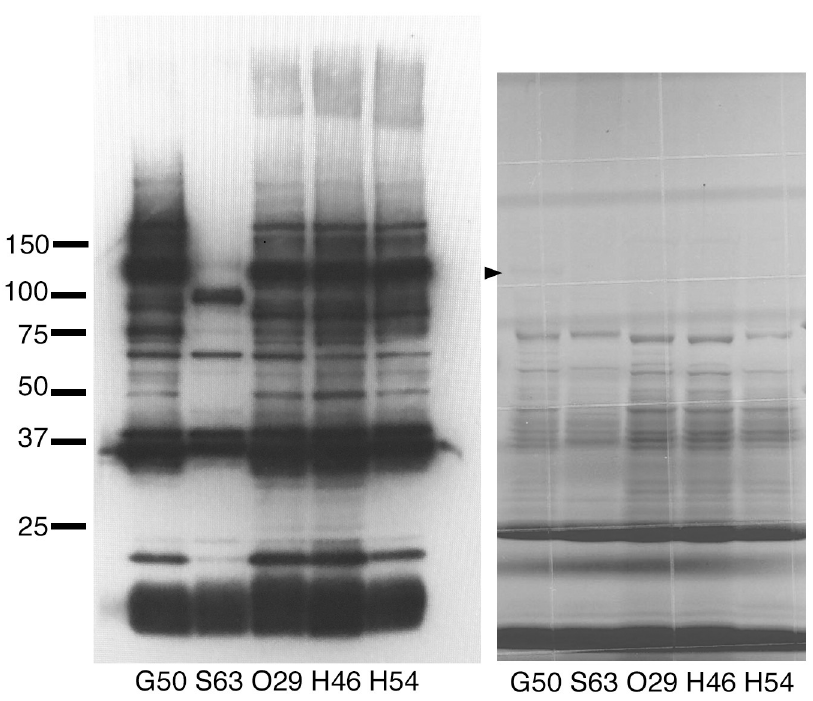
Fig 1. Western blot and Coomassie Brilliant Blue staining of lactococcal cell-wall proteins. (A) Western blot of cell-wall proteins of five lactococcal strains using anti-G50 antibody. (B) Coomassie Brilliant Blue staining of the same samples. The black triangle indicates the thin band of the 120-kDa protein.